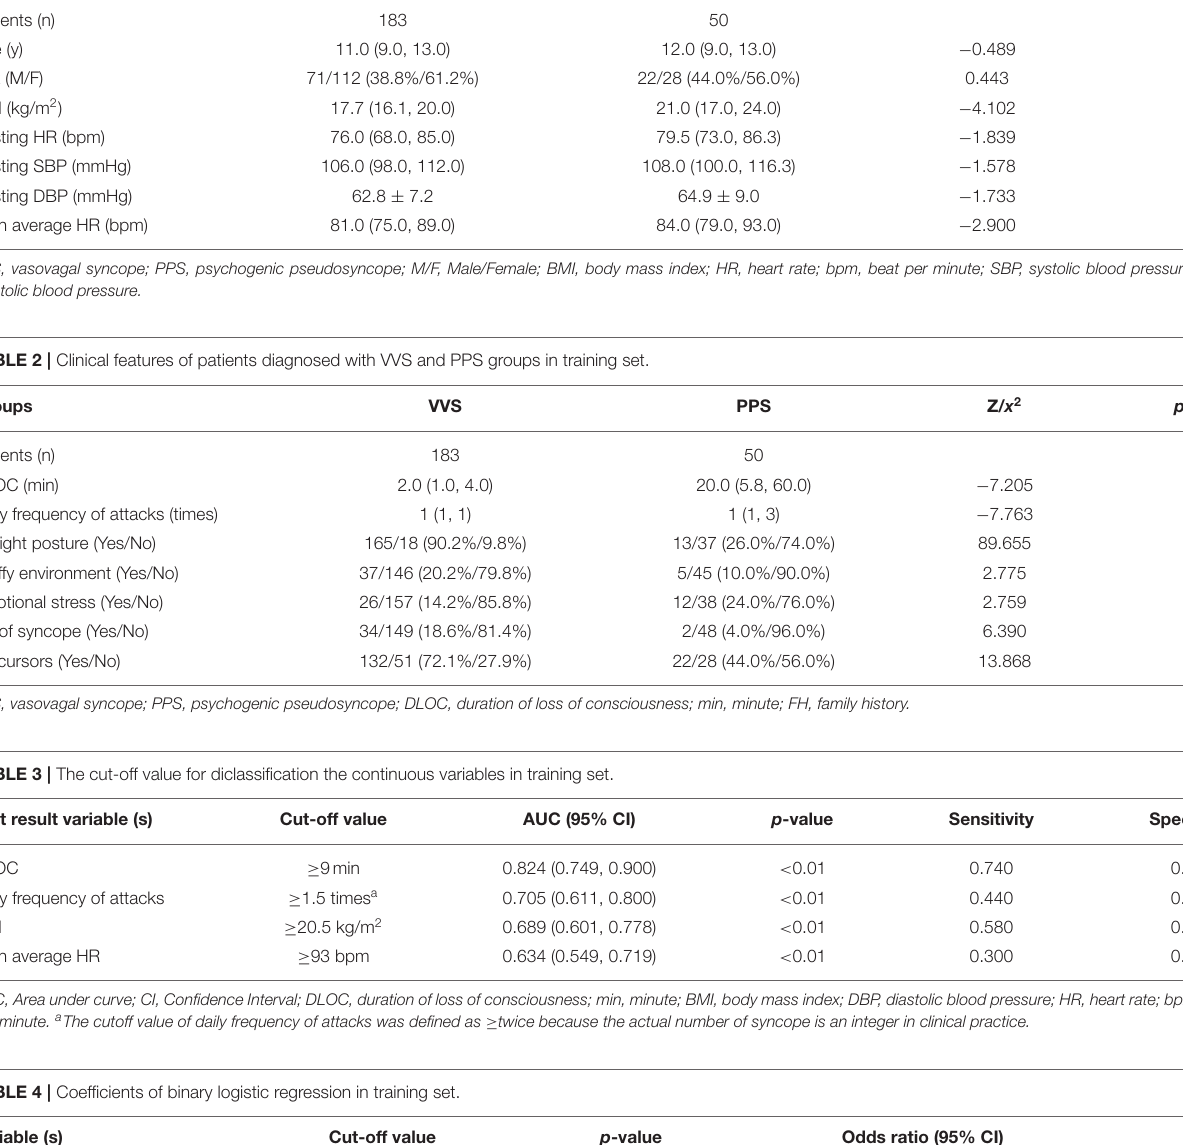
TABLE 1 | Comparison of the demographic characteristics between the VVS and PPS groups in training set. Groups